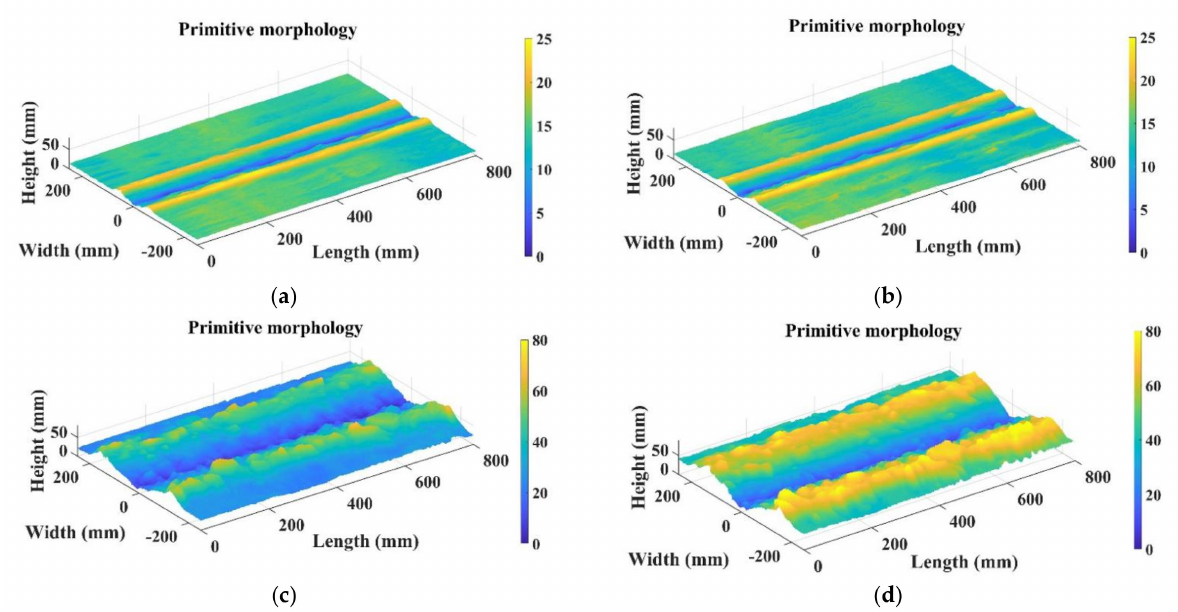
Figure 7. Digital model of soil surface. ( a ) Ditching depth of 5 cm. ( b ) Ditching depth of 8 cm. ( c ) Ditching depth of 10 cm. ( d ) Ditching depth of 12